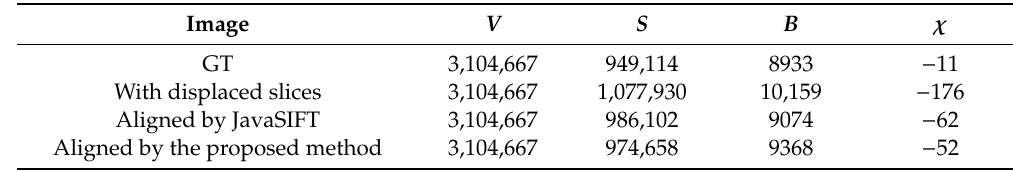
Table 2. Minkowski functionals for the synthetic sample.